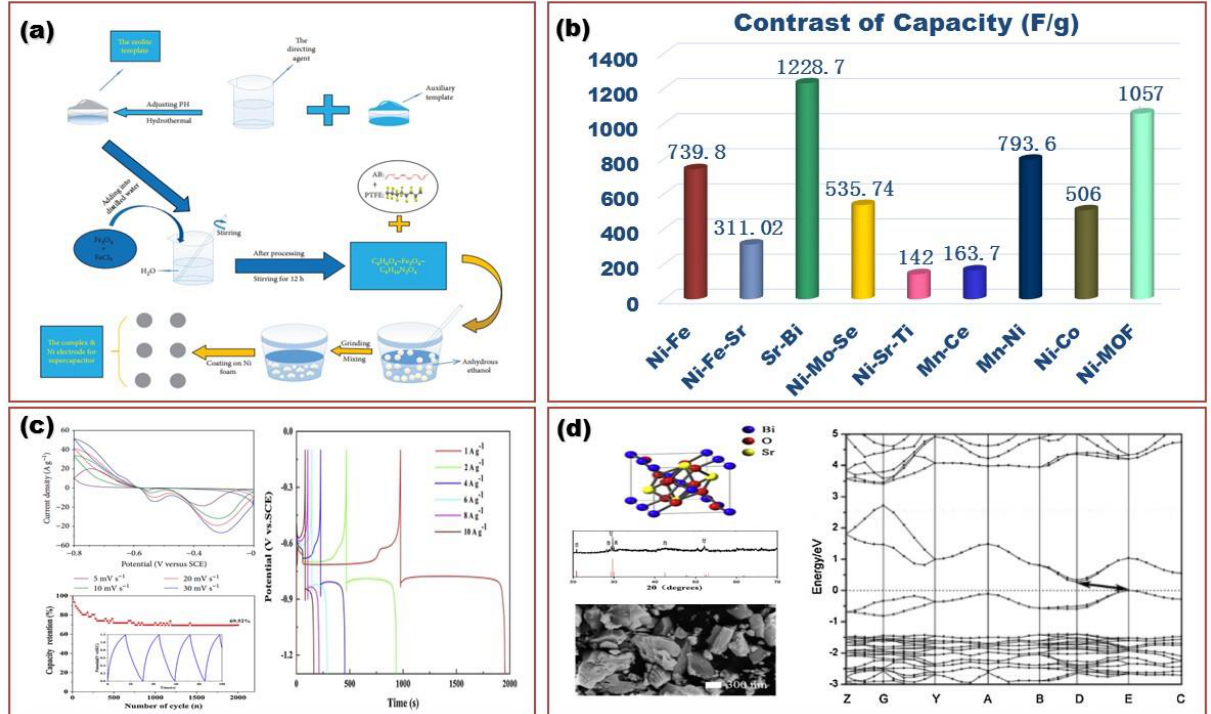
Figure 2. Electrode materials and typical pseudocapacitances. ( a ) the preparation process of pseu- docapacitance [15], Open Access, ( b ) the contrast of the specific capacitance properties of various bimetallic or multi-metallic oxides pseudocapacitance electrode materials, ( c ) CV curve, cycling performance, and GCD curves of the Sr-Bi bimetallic oxides pseudocapacitance electrode [16], Open Access ( d ) Micro-model, XRD pattern, SEM, and band structure of Sr-Bi bimetallic oxides [16], Open Access.